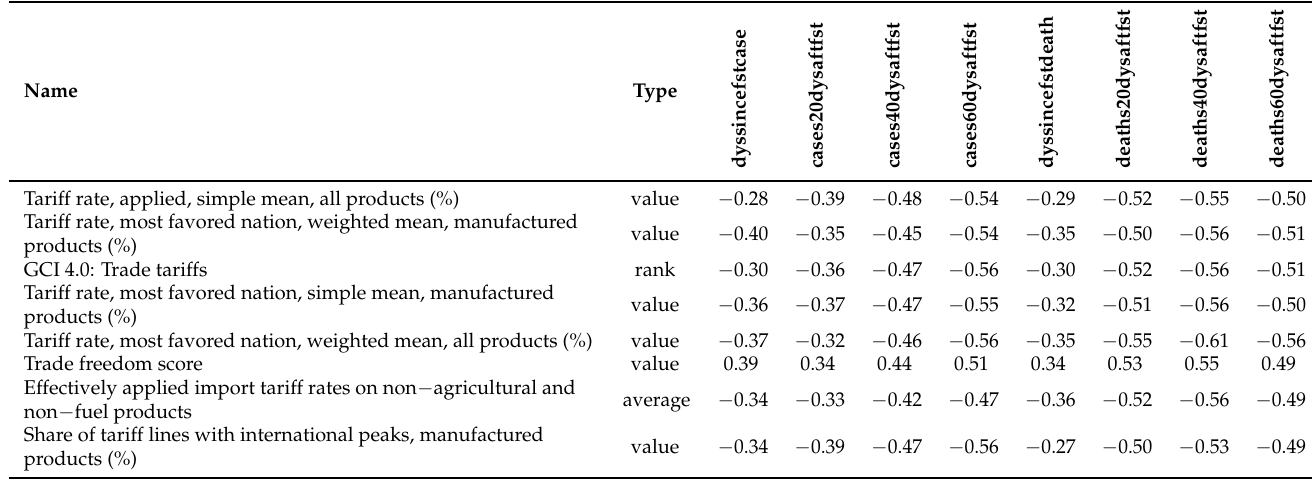
Table A5. Standalone correlations in the protectionism community. Spearman rank correlations between COVID-19 variables and indicators of the protectionism community in the worldwide